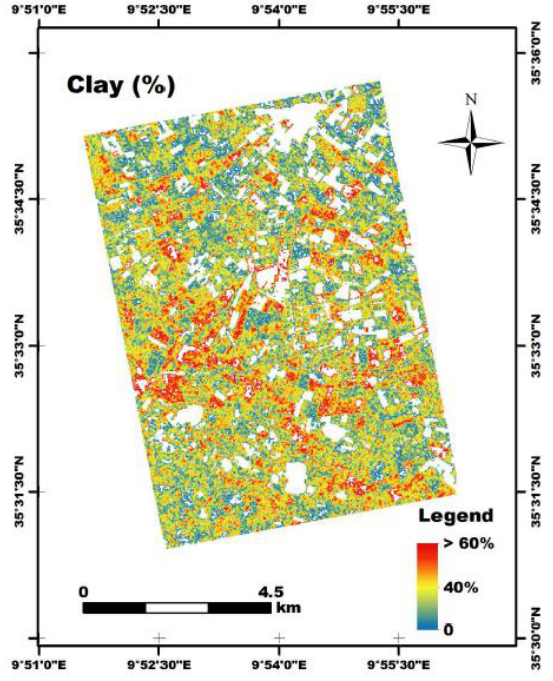
Figure 11. Map of soil clay